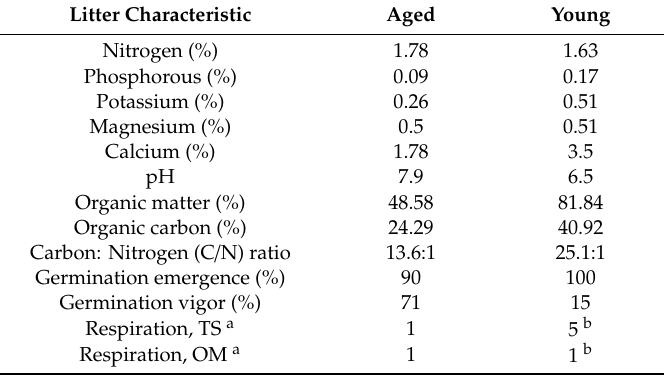
Table 1. Characteristics of the two types of leaf litter evaluated. Nutrient analysis conducted by A & L Great Lakes Laboratories, Fort Wayne, IN, USA. a Expressed as mg carbon (from CO 2 ) per gram per day. TS = total solids, OM = organic matter. b Respiration may have been reduced by earlier autoclaving and subsequent dry